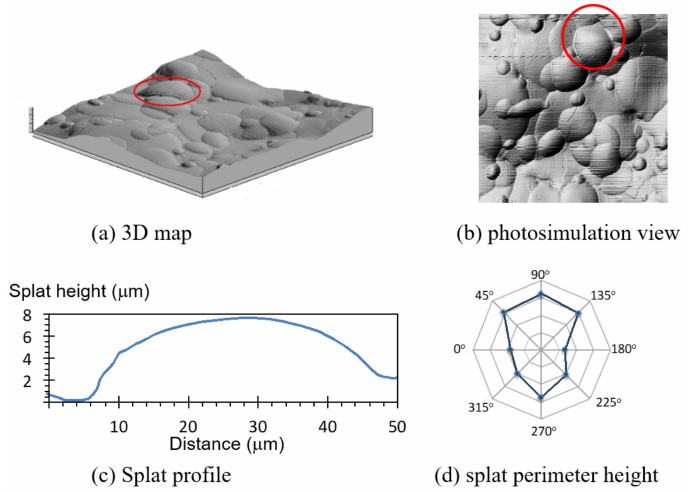
Figure 5. A topographical map from 20–40 µ m droplets measured by profilometry ( a ) in a 3D map of a 200 µ m × 200 µ m section and ( b ) in a photosimulation view. A more detailed analysis of the circled Splat shows ( c ) a profile view of a Splat at a 0 ◦ –180 ◦ section, and ( d ) the Splat height at di ff erent rotations. The orientation of ( b ) and ( d ) are identical to show the influence of surrounding Splats on the measured Splat height. The webs on the radar plot start at 0, with height increments of 4 µ m. Splat height at the circumference varied in response to the underlying surface contour and surrounding splat proximity. A line profile on a close-to-horizontal reference plane showed a similar ◦ ◦ splat height at opposite ends (orientation 0 –180 ; Figure 5c). Line profiles taken at other